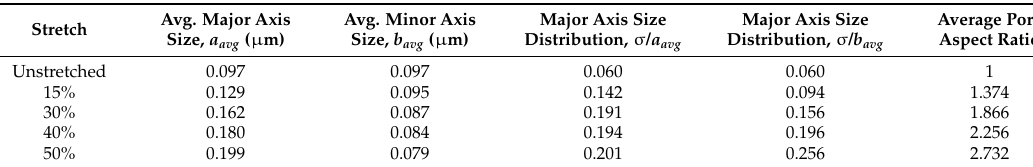
Table 2. Size distribution parameters for stretched membranes.